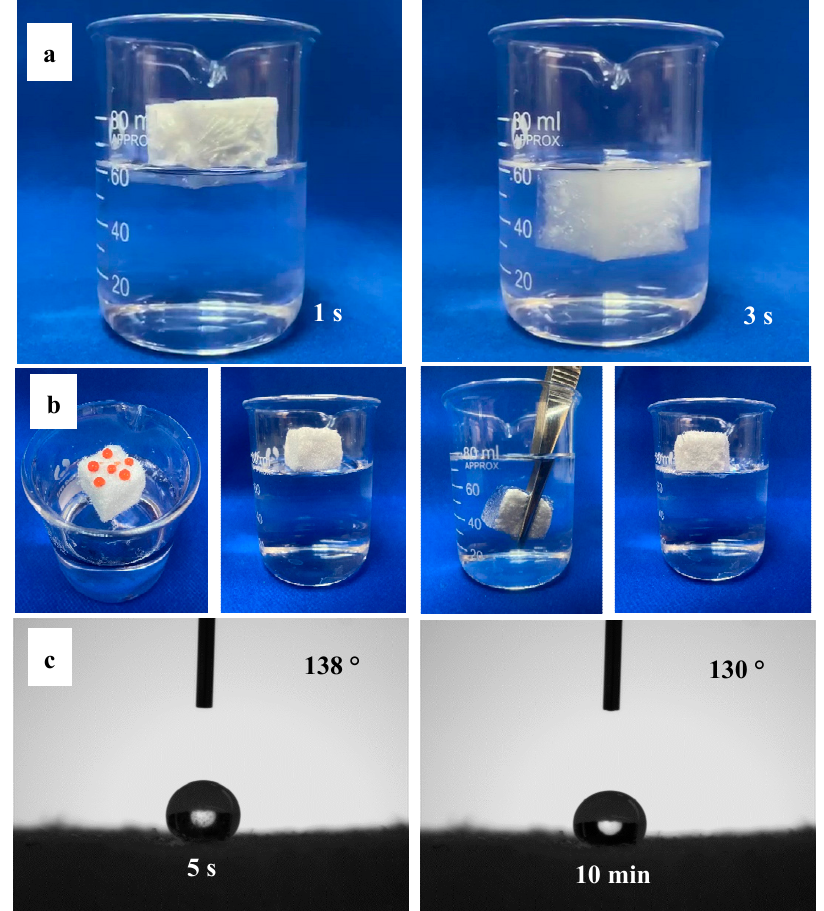
Figure 9. Hydrophobicity of ( a ) HCNF and ( b ) HCNF / APP / MTMS aerogels, and ( c ) water contact angles of the HCNF / APP / MTMS aeroge measured at 5 s and 10 min. Table 3. Cone calorimeter data of the HCNF, HCNF/APP, HCNF/APP/MTMS aerogels.